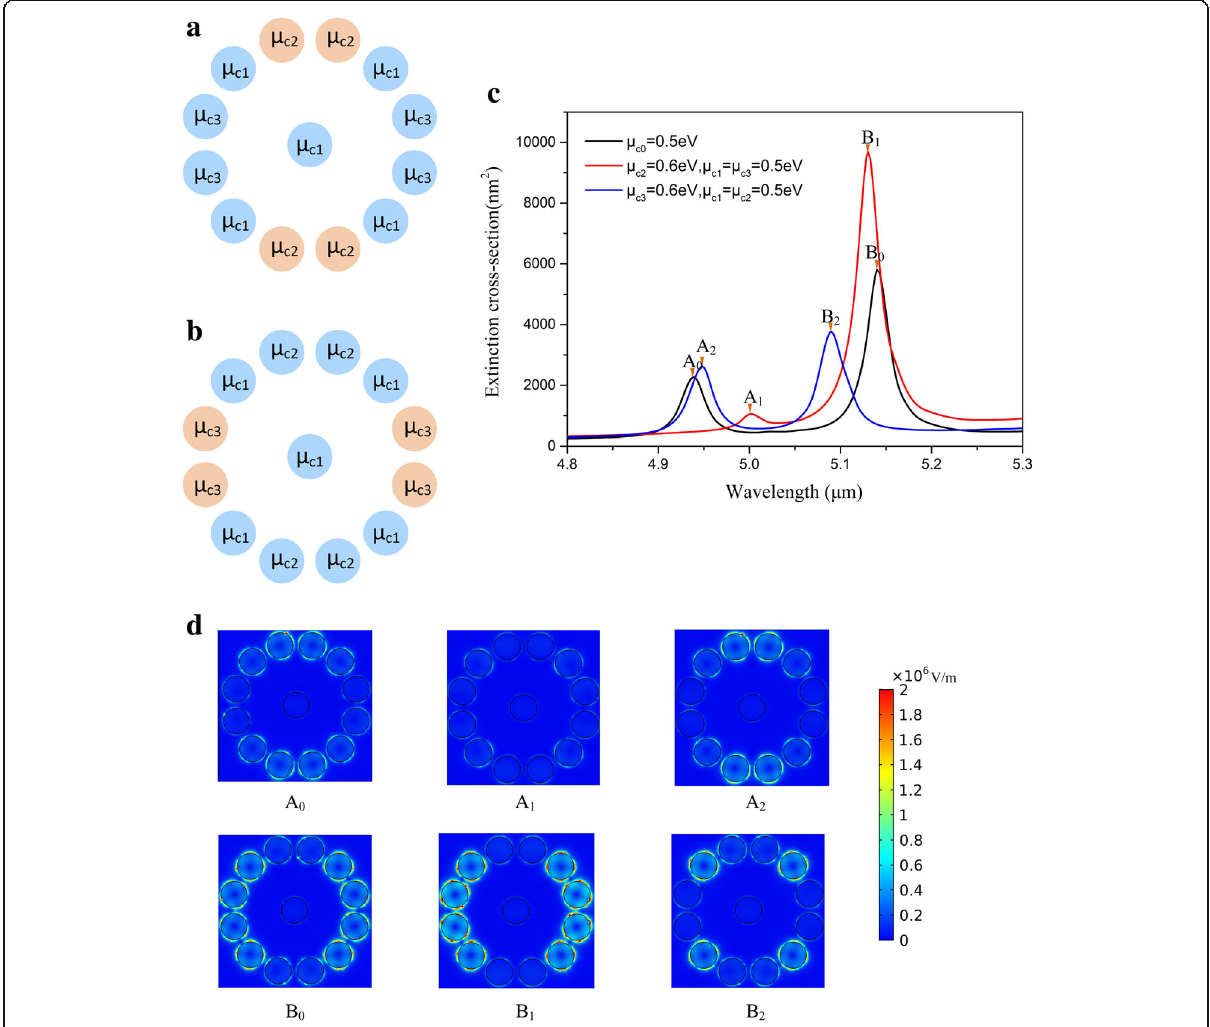
Fig. 3 a , b Schematic illustration of selectional graphene nanodisks with different chemical potential change in graphene oligomer. c The extinction spectra with different chemical potentials. d The simulated electric field (|E|) at the resonance peaks A 0 , A 1 and A 2 , B 0 , B 1 and B